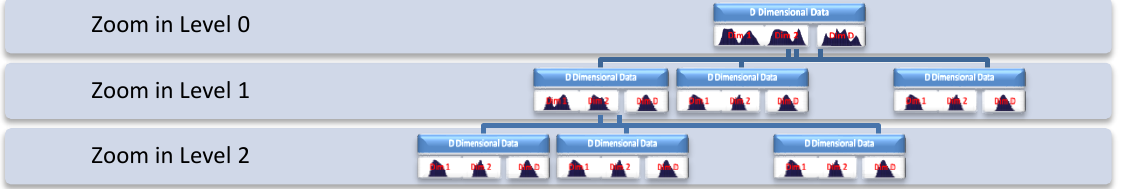
Figure 5. Hierarchical structure of the HUALM